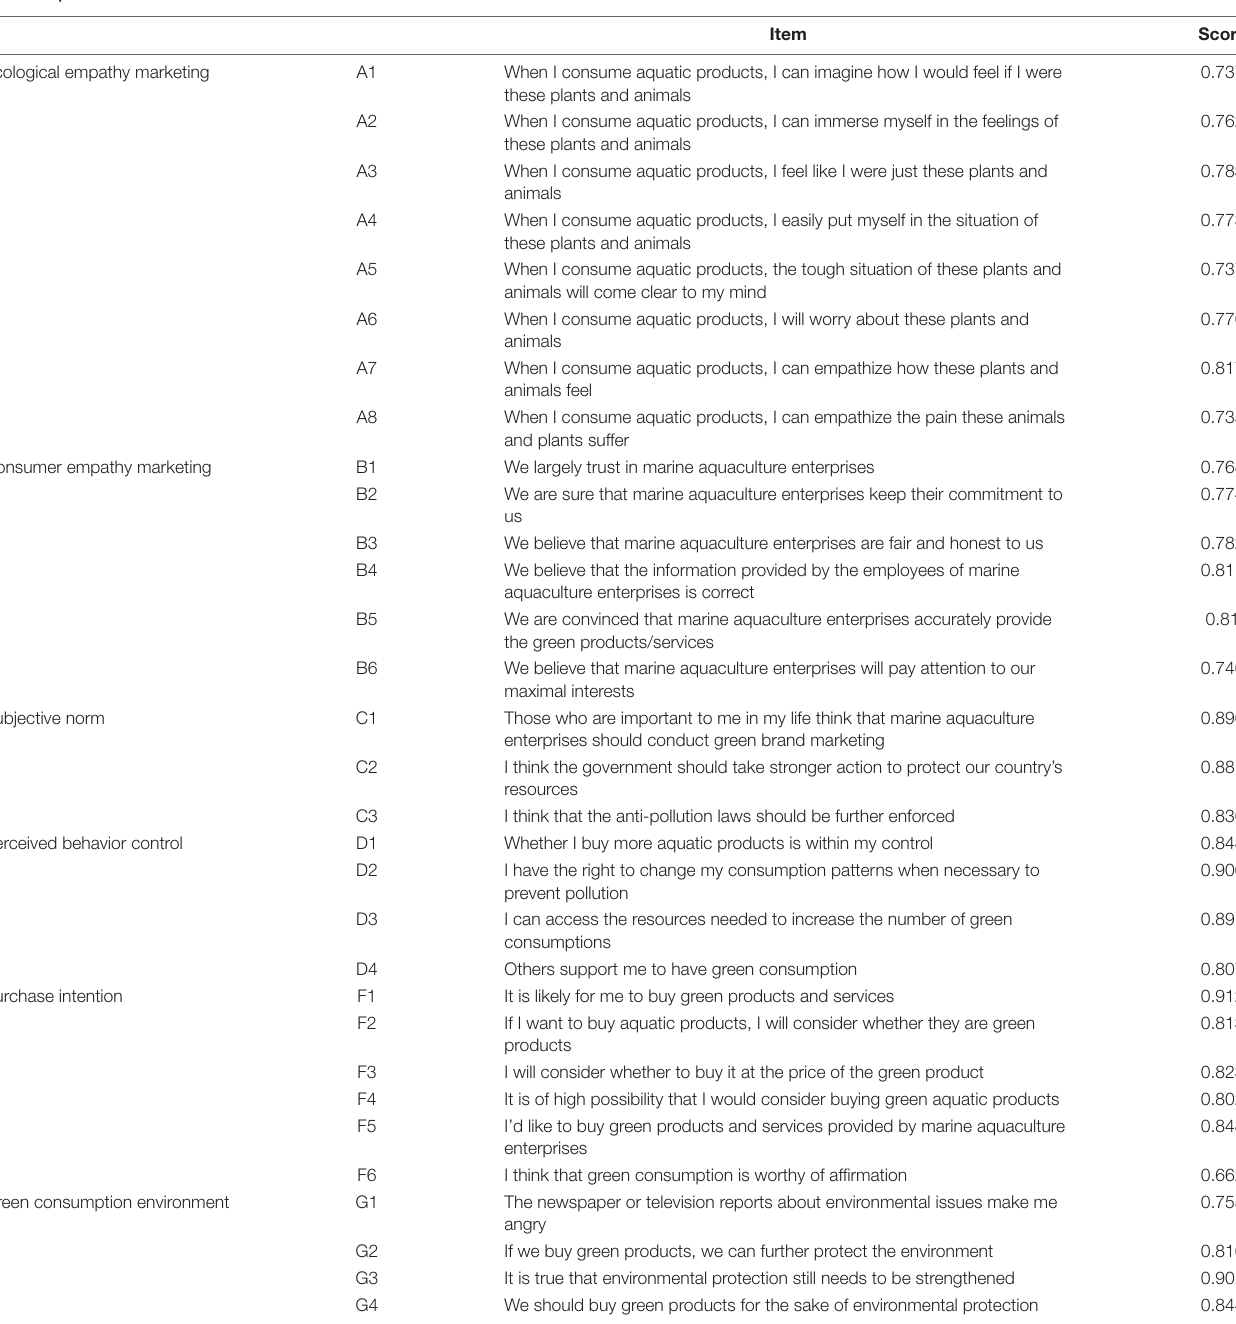
TABLE 2 | External model